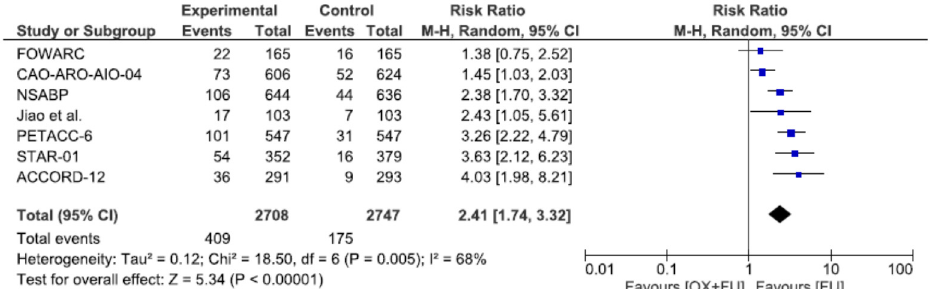
Figure 9. Forest plot of risk ratio for digestive toxicity.